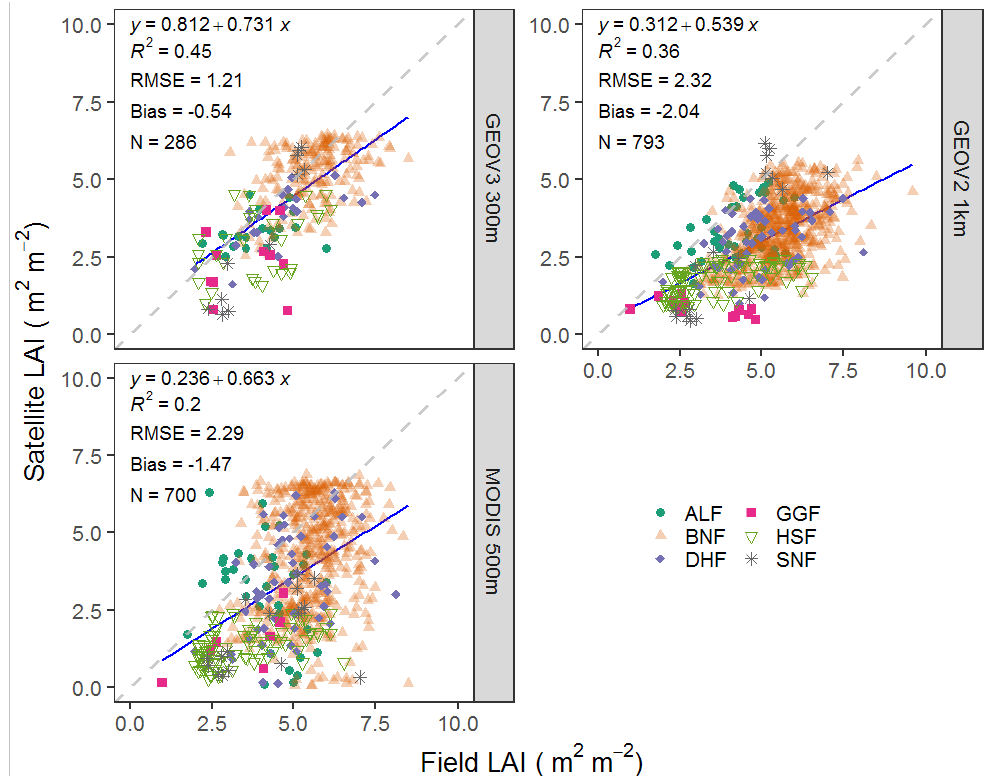
Figure 3. Regression between the field LAI and the satellite retrieved LAI. Each point represents the monthly LAI field measurement against the satellite LAI retrieval. The blue solid lines represent the regression between the field LAI against the satellite LAI for all the sites combined on a monthly scale. Point colors and shapes represent different sites.